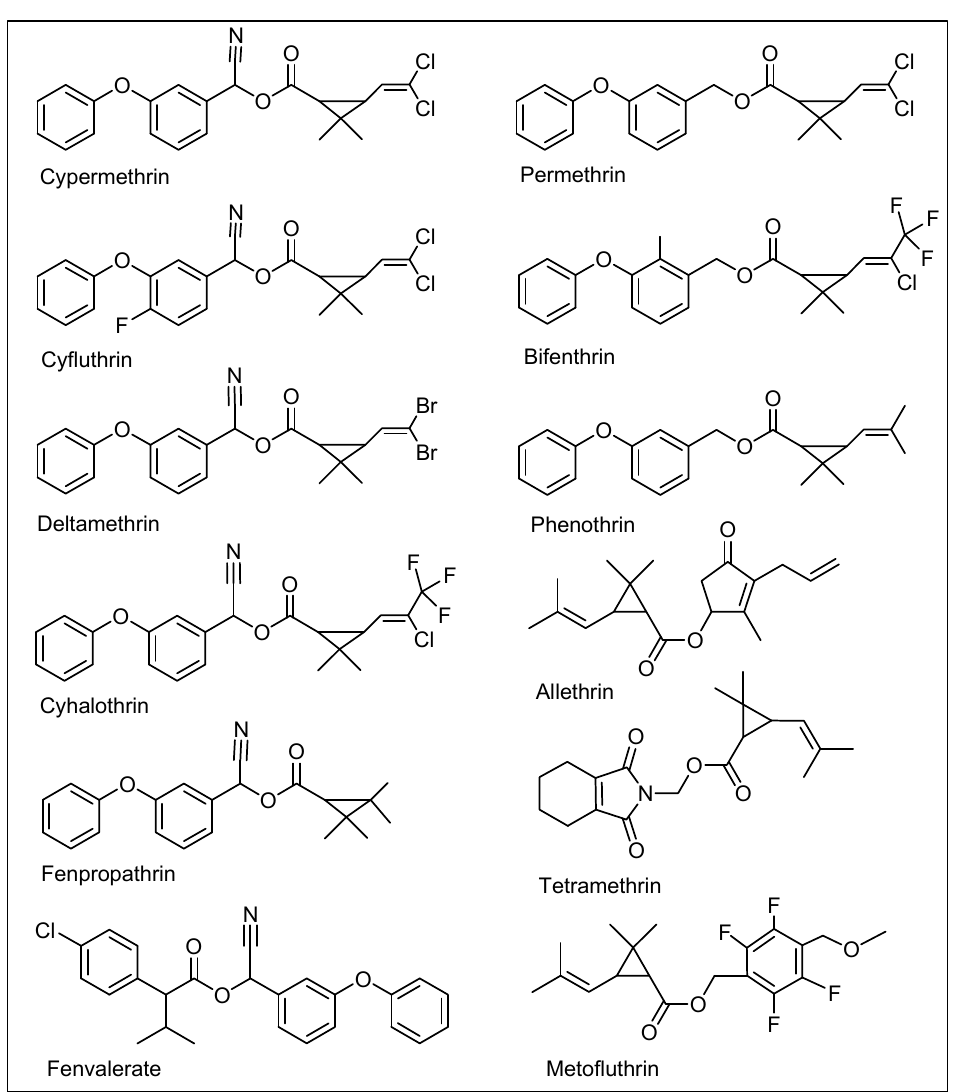
Figure 1. Chemical structures of major cyano, and non-cyano pyrethrins.